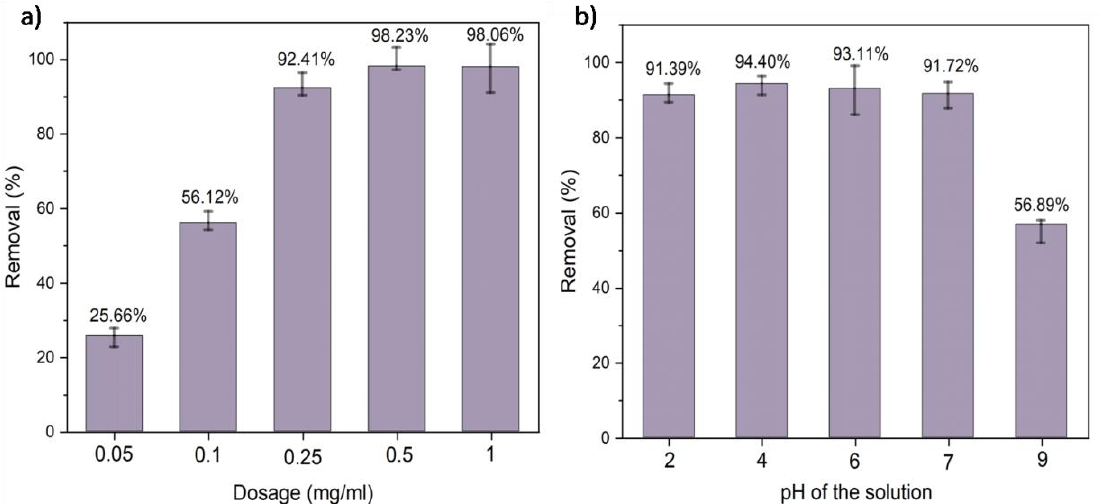
Figure 5. Removal (%) ( a ) at different dosage of adsorbent (pH = 6, adsorbent dosage = 0.25 mg/mL to 1 mg/mL, Cr concentration = 10 ppm, contact time = 30 min) and ( b ) at different pH values of the aqueous chromium solution (adsorbent dosage = 0.25 mg/mL, Cr concentration = 10 ppm, contact time = 30 min).